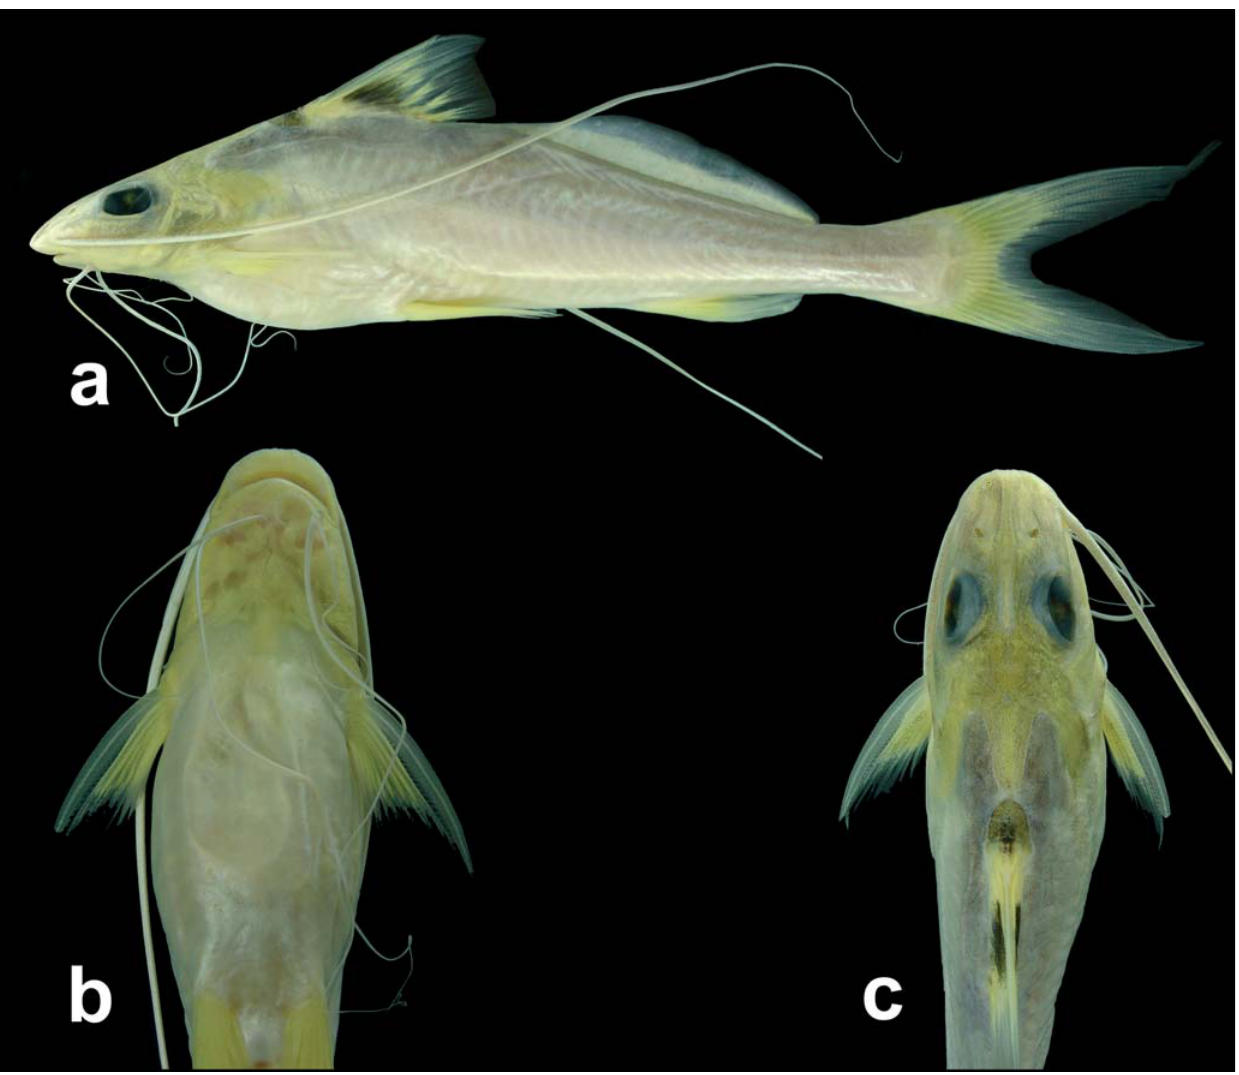
Fig. 1. Propimelodus araguayae , INPA 26119, holotype, 127.1 mm SL. a, lateral view; b, ventral view of head; c, dorsal view of head. Photographs by F. P.